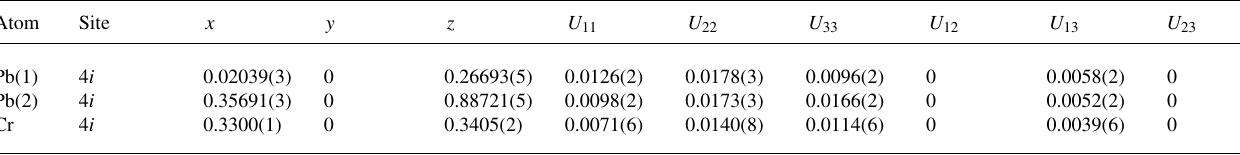
Table 2. Atomic coordinates and displacement parameters (in Å 2 )